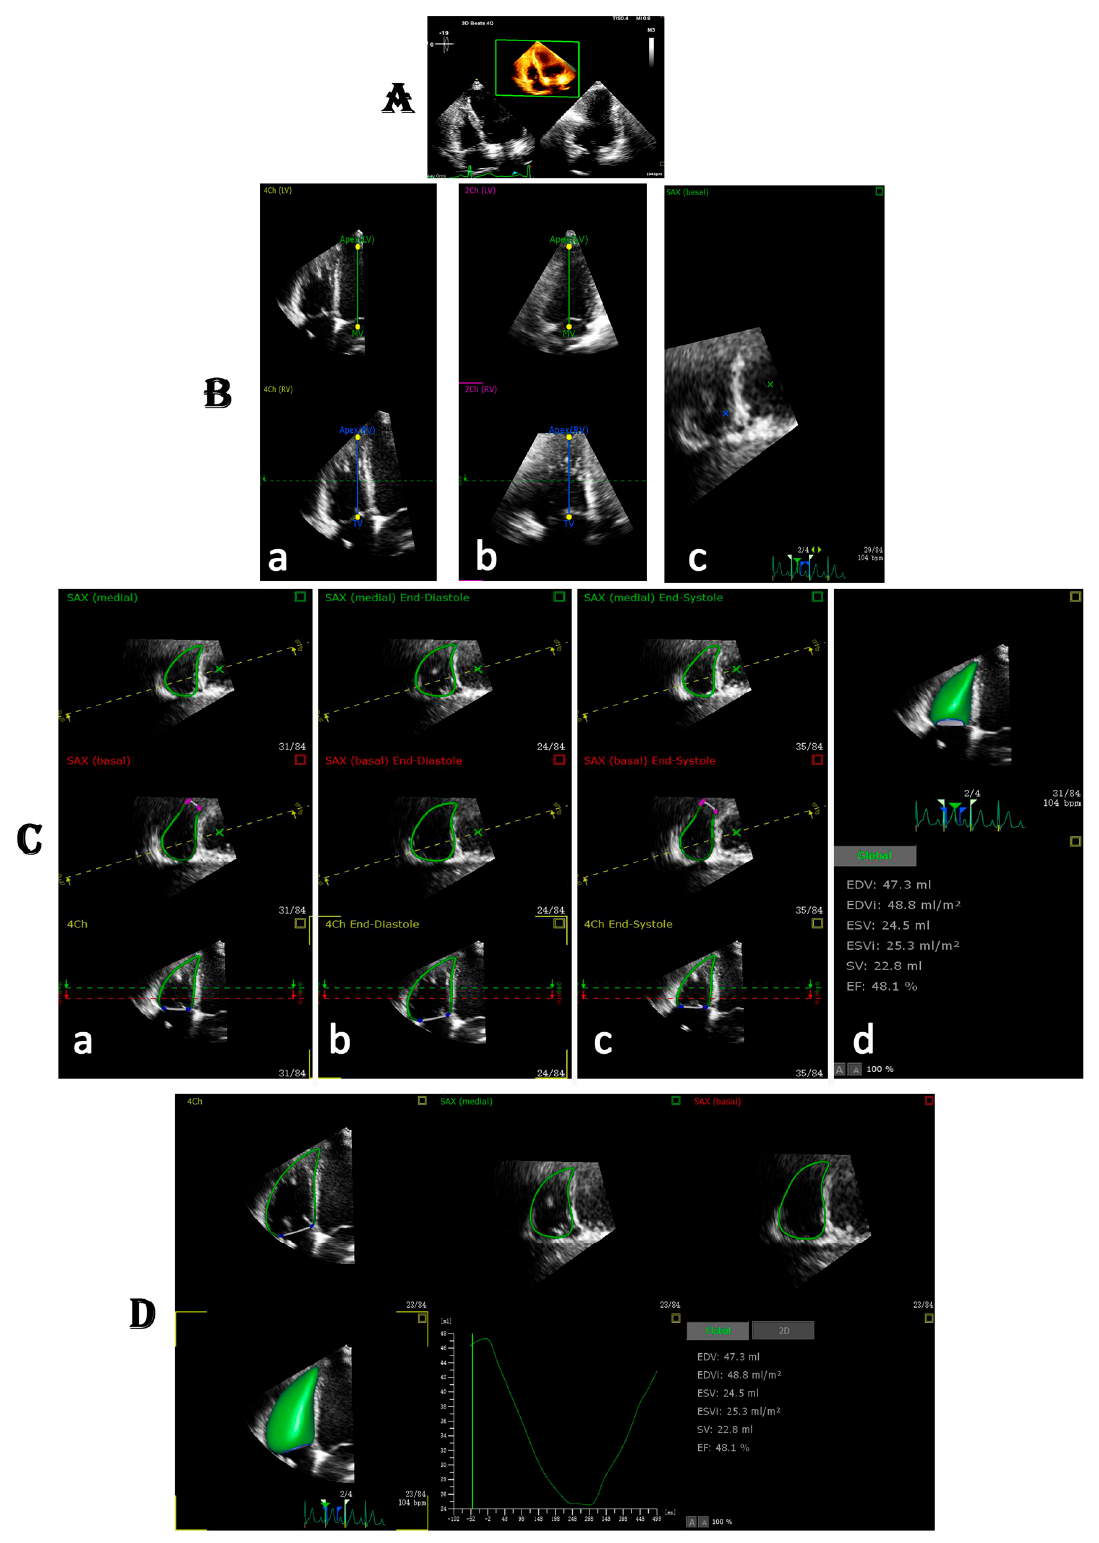
Figure 1. Shows the process of Auto RV analysis. ( A ) retrieving the RV focus three-dimensional echocardiography (3DE) data set aiming for RV analysis, ( B ) the software automatically adjusts the five landmarks: 4C LV and RV (a); 2C LV and RV (b) and basal SAX (c), ( C ) and the software automatically determine the RV border at 4C view (a); at end-diastole (b); end-systole (c) and retrieve the global analysis (d). ( D ) and provide the results within 15